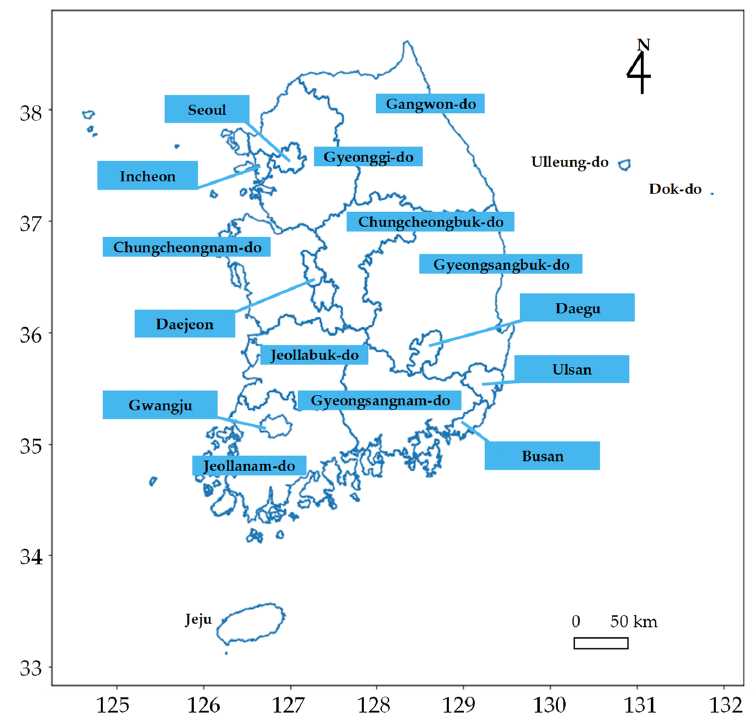
Figure 3. Location of major cities and provinces in South Korea.